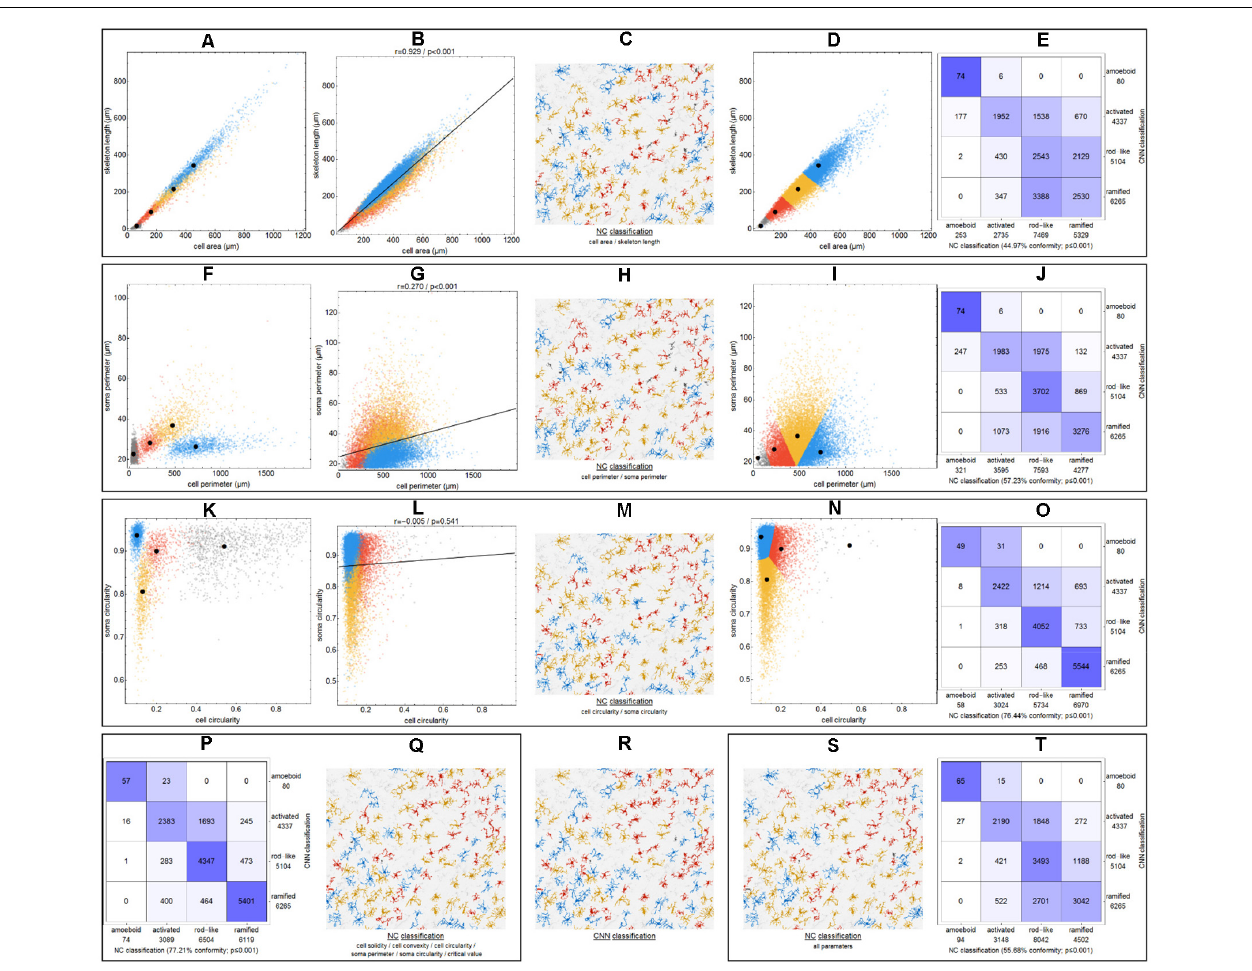
FIGURE 4 | Differences between CNN classification and NC (nearest centroid) classification for various parameter combinations. Scatter plots with respective class centroids (black points) of all manually selected cells (A,F,K) . Scatter plots of all cells after CNN classification (B,G,L) with regression line. Scatter plots of all cells with initial class centroids (black points) after NC classification (D,I,N) . Comparison of CNN and NC classification results with degree of conformity and p-value from exact symmetry test for paired contingency tables (E,J,O,P,T) . Example image section with color-codings for CNN classification (R) and NC classifications (C,H,M,Q,S) . Ramified microglia are depicted in blue, rod-like cells in orange, activated microglial cells in red, and amoeboid cells in